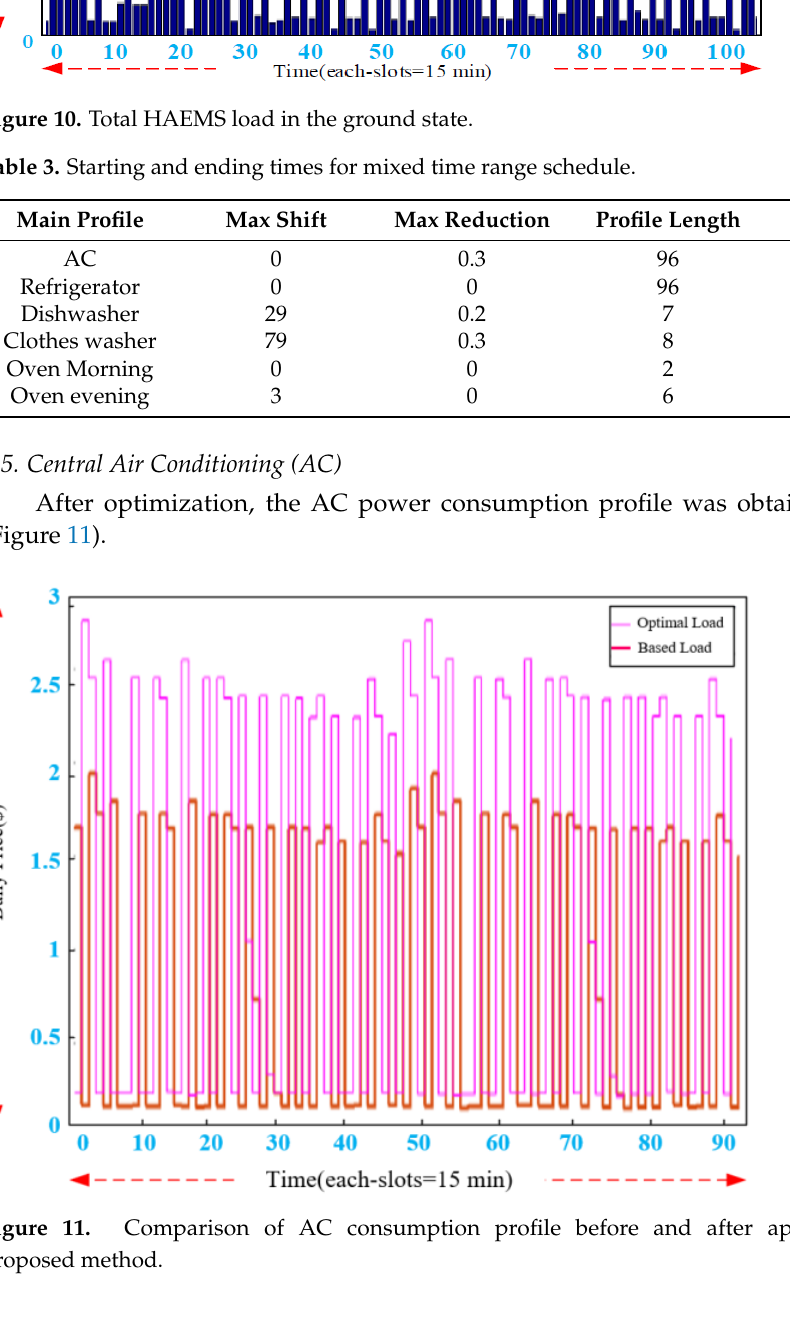
method. proposed